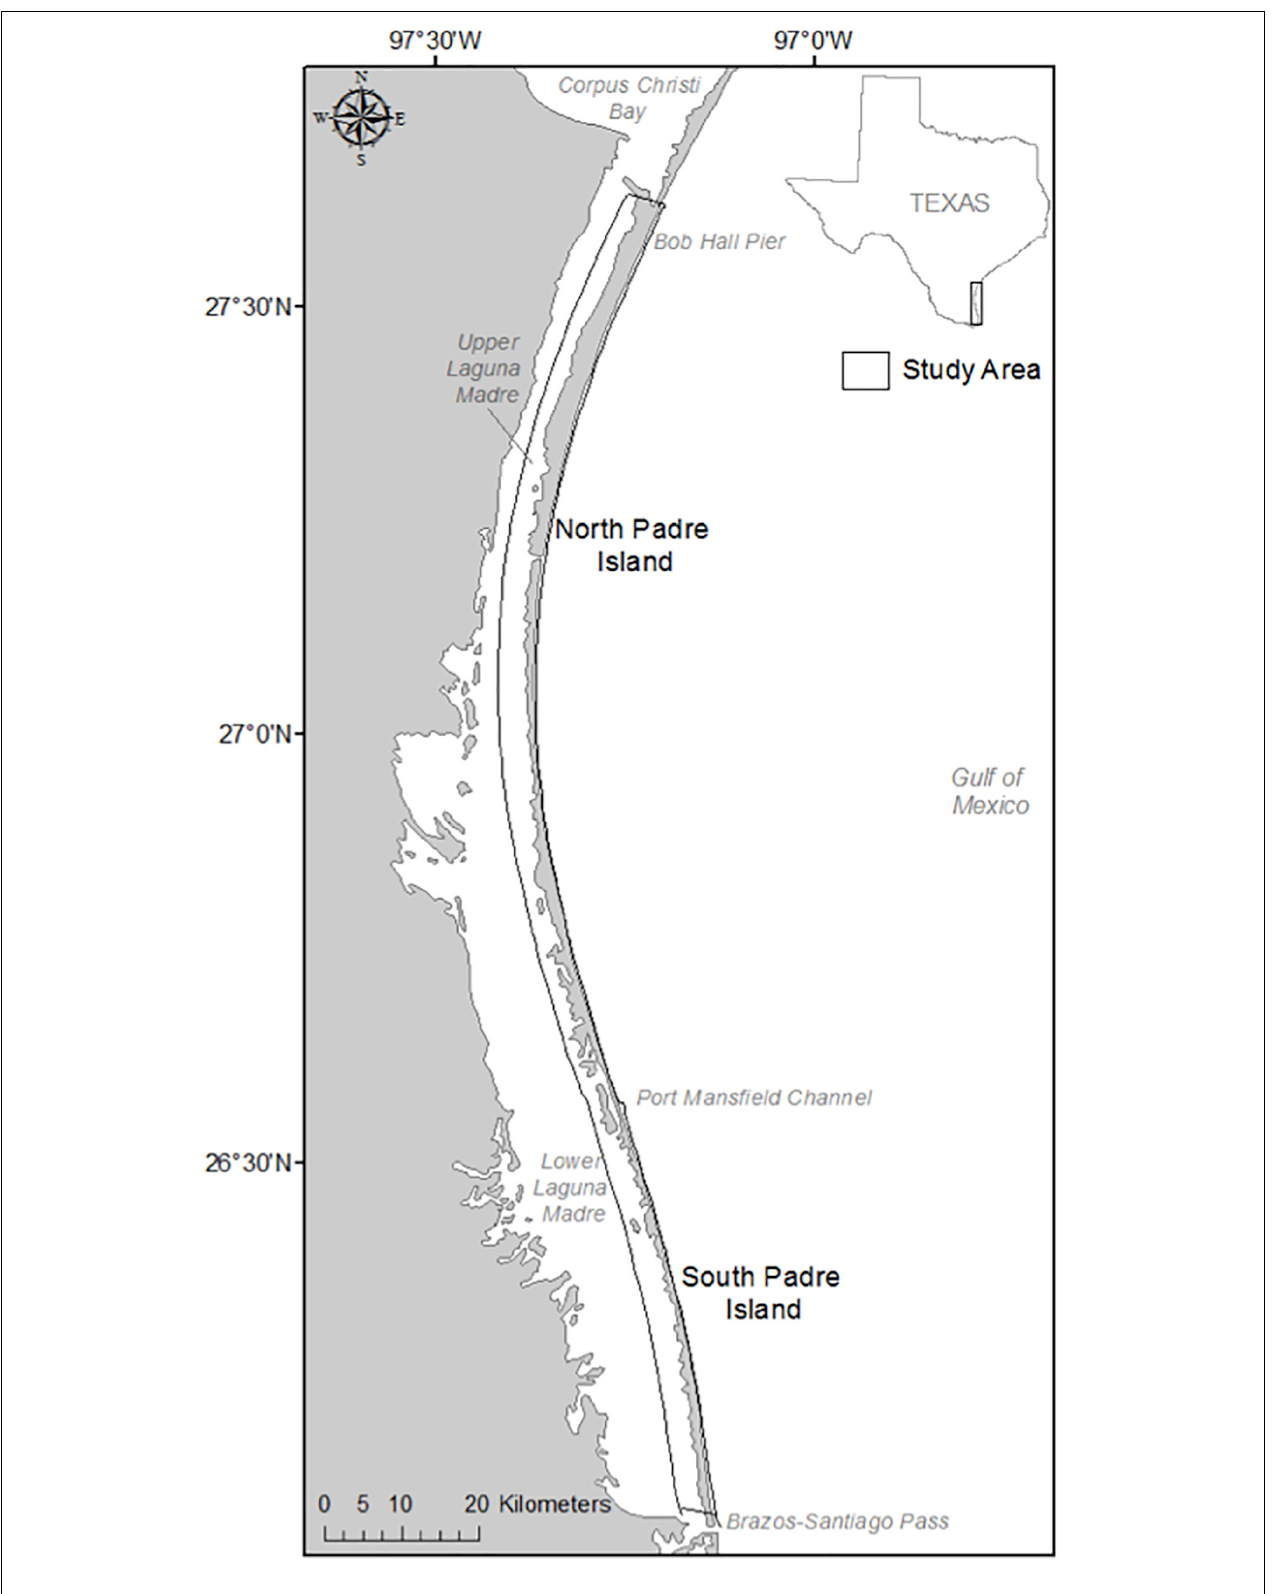
FIGURE 1 | The study area of the research, the beaches of North and South Padre Islands, TX, United States.